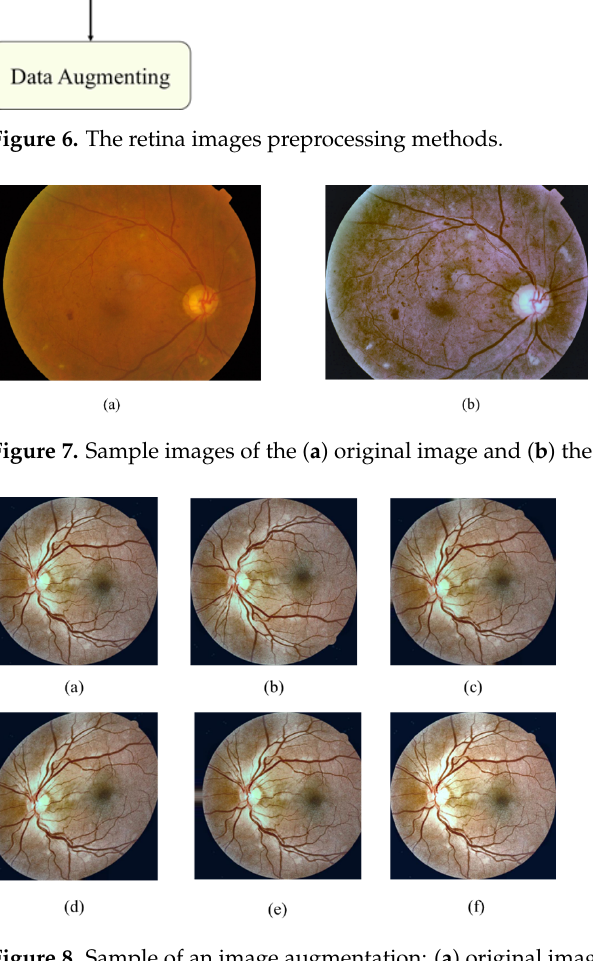
Figure 8. Sample of an image augmentation: ( a ) original image, ( b ) flipped image, ( c ) rotated image, ( d ) sheared image, ( e ) translated image and ( f ) brightened